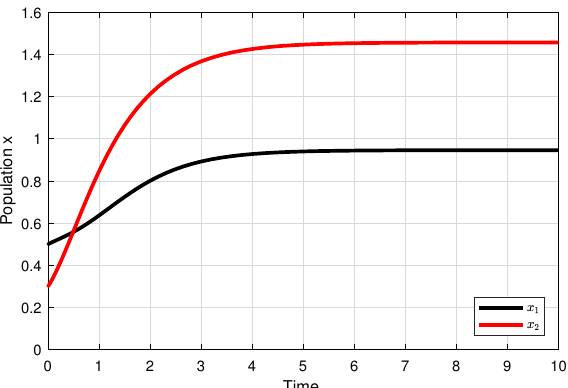
Figure 5. Evolution over time of the occupancy levels of two patches with different noise levels (more noise: black line; less noise: red line), when noise intensity is high. In this simulation, k = 3, i.e., the carrying capacity of the noisy patch ( K 1 ) is higher than that of the less noisy patch ( K 2